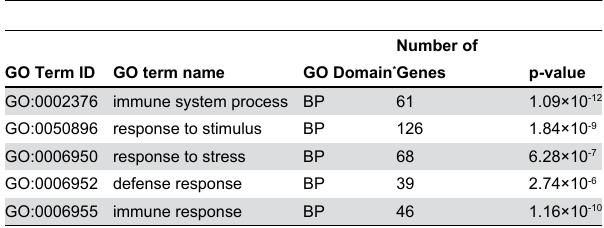
Table 3. Over-represented GO terms for genes with CRP- associated DNAm sites.